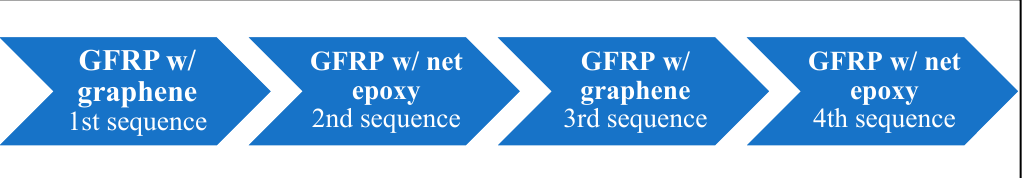
Figure 4. Running order of the machining sequences.